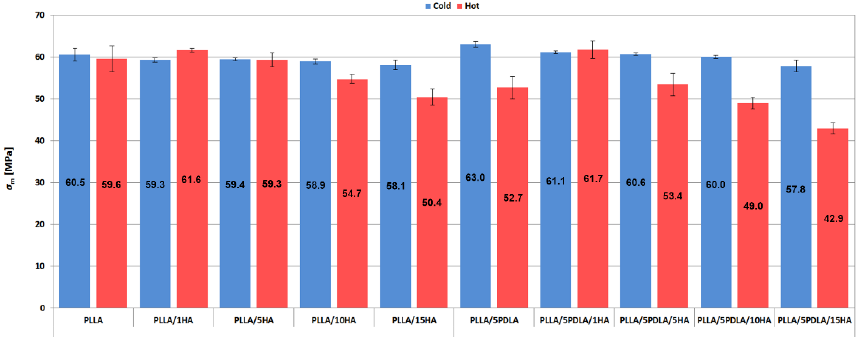
Figure 4. Tensile strength plots of samples from cold and hot molds.